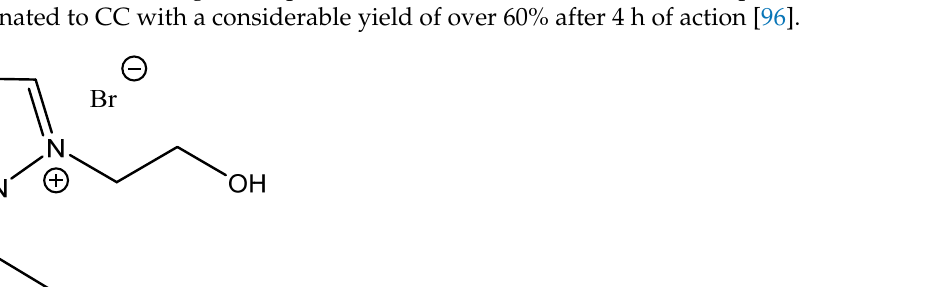
Scheme 11. Carbonation of EPIC using simulated flue gas (15% CO 2 in nitrogen) catalyzed by OH-functionalized DBU-based IL at ambient pressure and at 30 °C [95].